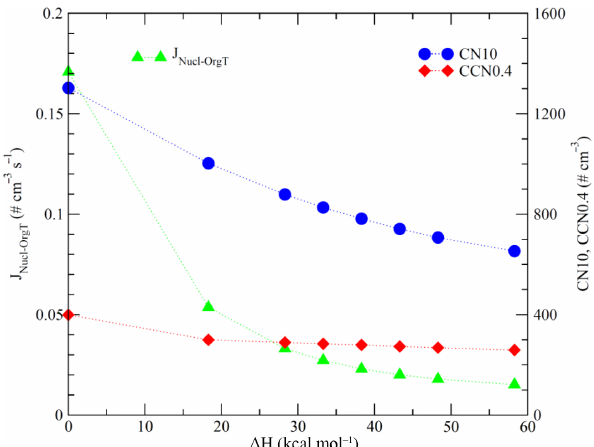
Figure 4. The dependence of organics-mediated nucleation rates (left axis). CN10 and CCN0.4 (right axis) averaged in the boundary layer (0–1km) over the whole globe for July 2006 on the (cid:49)H values assumed in calculating the temperature dependence cor- rection factor for the Nucl-Org parameterization ( f T )